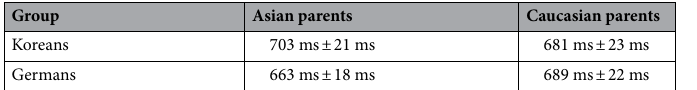
Table 4. Mean response times to the parent faces, ± standard error of the mean.